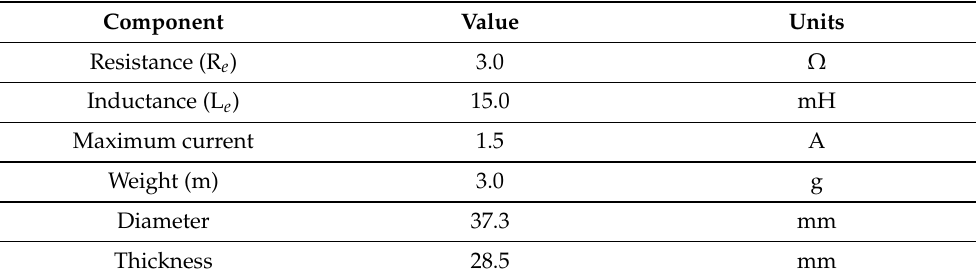
Figure 3. Position sensor and electromagnet arrangement. The parameters values of the system are listed on Table 1, where the weight, diameter, and thickness correspond to the disc. Table 1. Parameters of the system [28].